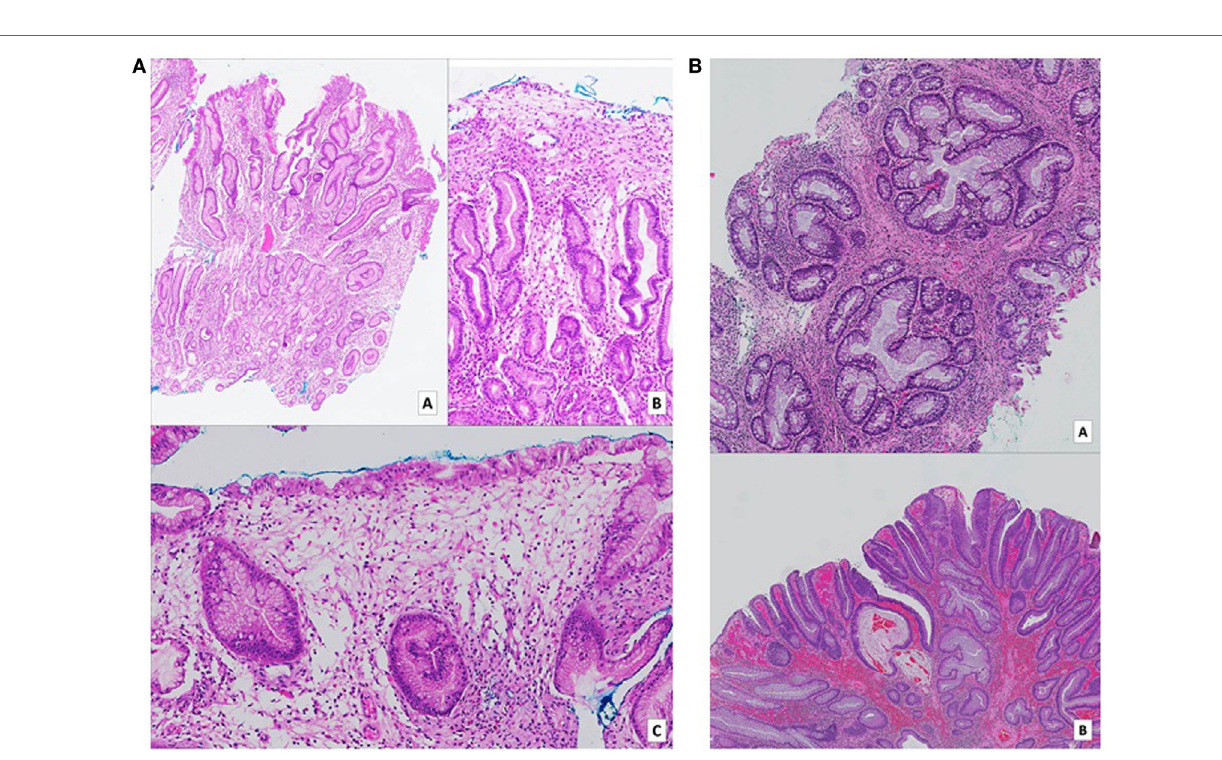
FIGURe 2 | (a) Gastric biopsies taken at time of diagnosis. Numerous pieces from various parts of the stomach show similar features. On low (a – H&E, 2 × magnification) and medium (b – H&E, 10 × magnification) power views, tortuous hyperplastic glands with occasional mild branching and dilatation are identified. A different field (c – H&E, 10 × magnification) demonstrates an area of prominent lamina propria edema with a mixed inflammatory cell infiltrate including eosinophils. (B) (a – H&E, 5 × magnification) (b – H&E, 2 × magnification): biopsies of colonic hamartomatous polyps taken a year after diagnosis. The crypts are tortuous, and some are cystically dilated secondary to inspissated mucin. The intervening lamina propria shows an infiltrate of predominantly mononuclear cells, as well as occasional hypertrophic strands of smooth muscle cells. (B) Shows a focus of low-grade dysplasia arising on the background of a hamartomatous